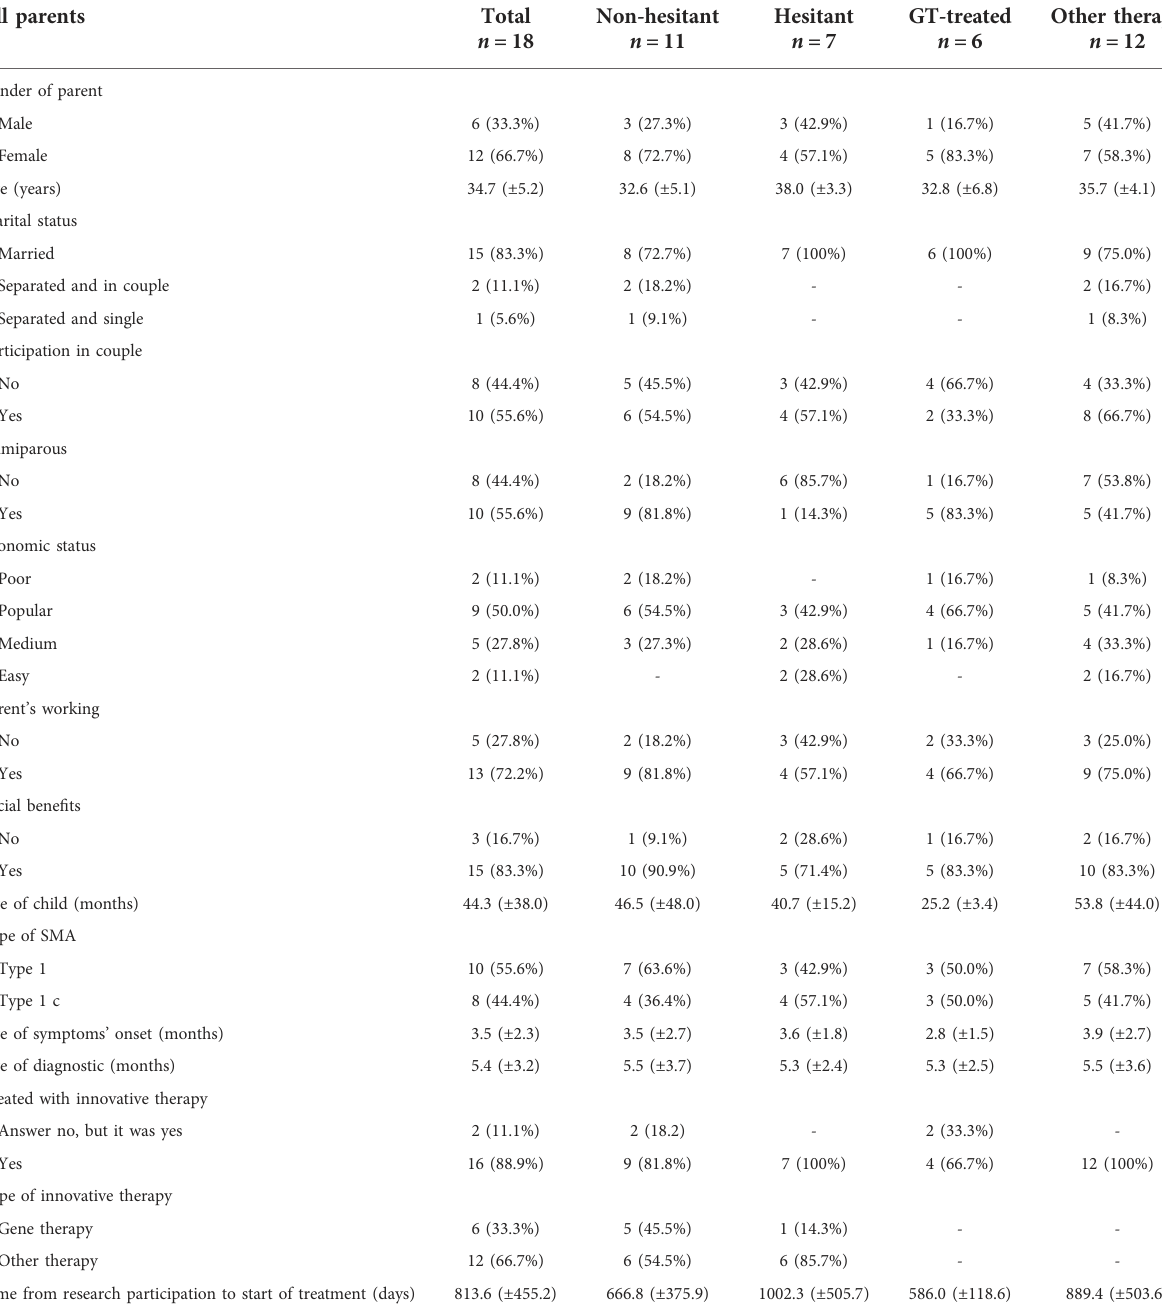
TABLE 1 Characteristics of participants ( n =18, homemade self-reported